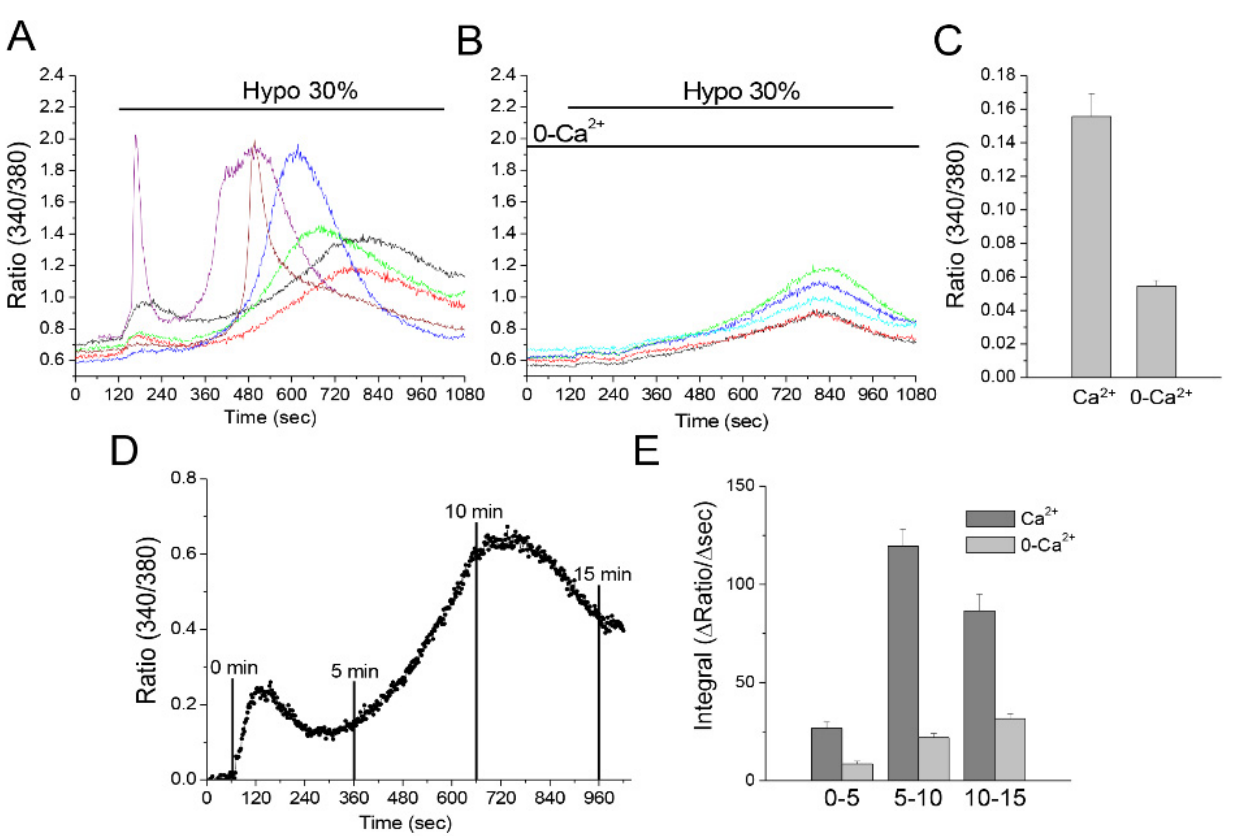
Figure 6. Ca 2+ movements in U251 cells in response to hyposmotic challenge. Fura-2-loaded MLC1- WT expressing U251 cells were exposed to hyposmotic solution for 15 min in the presence of Ca 2+ (2.5 mM), or in a 0-Ca 2+ solution (Ca 2+ replaced by Mg 2+ and with EGTA 0.5 mM). Exemplificative traces recorded in the presence ( A ) or absence of Ca 2+ ( B ) are shown. The amplitude of the Ca 2+ peak was calculated as the difference between the maximum value reached within the first 120 s of application of hyposmotic solution and the baseline value. Peak amplitudes are plotted in panel ( C ) (mean ± SEM of 90 and 65 cells, from 3 recordings for each condition). Areas underneath Ca 2+ transients at defined time intervals (0–5, 5–10 and 10–15 min) were calculated after baseline subtraction, as shown in panel ( D ), to represent actual Ca 2+ movements. Mean ± SEM of Δ Ratio/ Δ time at different time intervals are shown in panel ( E ) ( n = 72 and 65 cells, in Ca 2+ and 0-Ca 2+ , respectively).